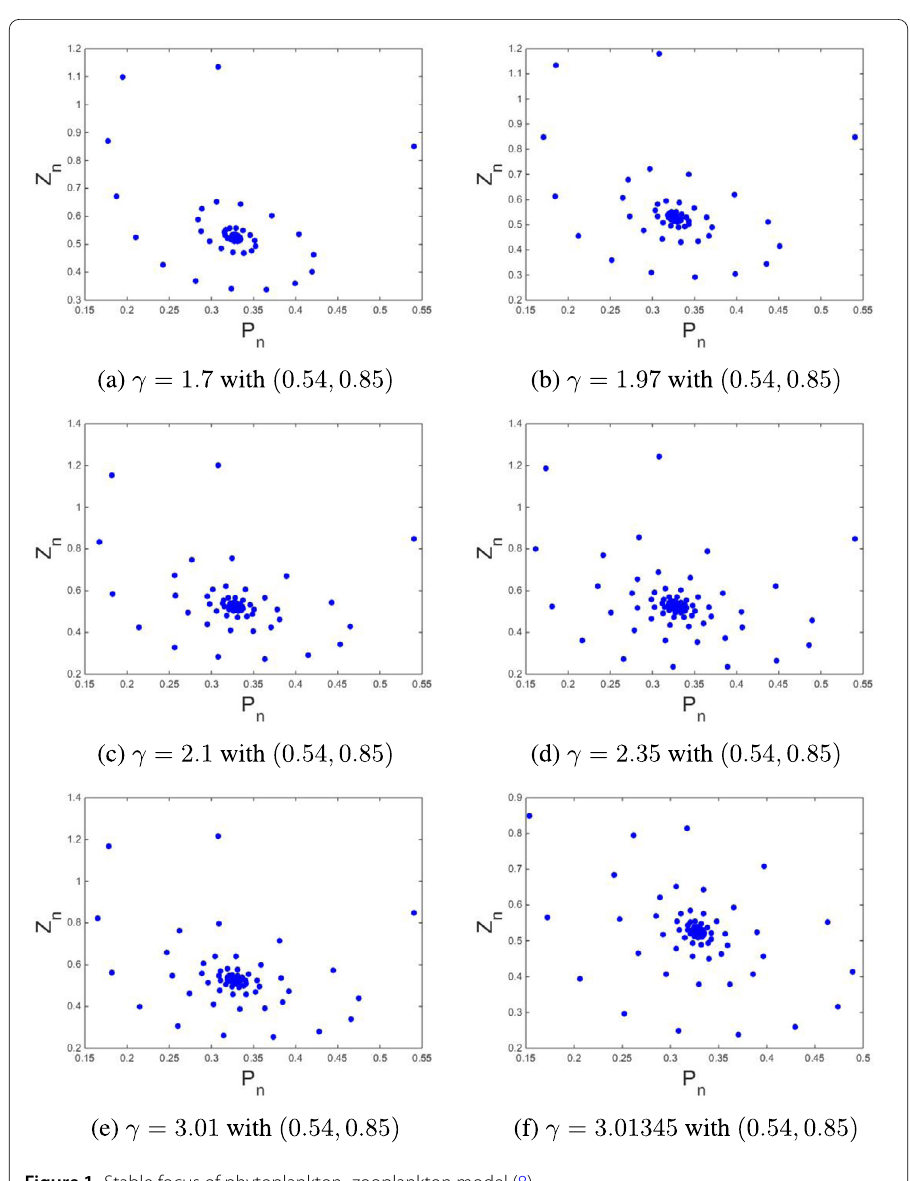
Figure 1 Stable focus of phytoplankton–zooplankton model (8)